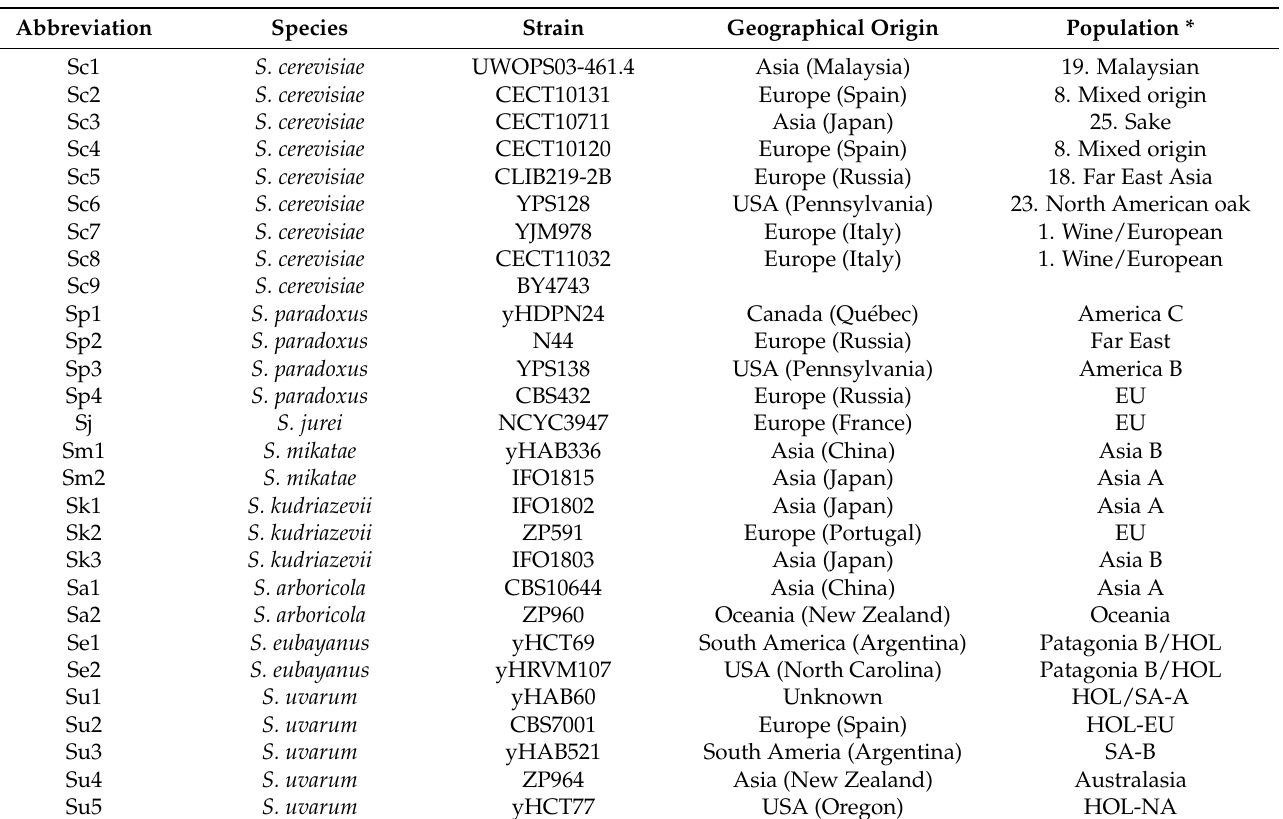
Table 1. Saccharomyces strains used in this work. Species are listed in order of evolutionary proximity to S. cerevisiae , according to the phylogenetic tree depicted in Figure 1. * Classification according to References